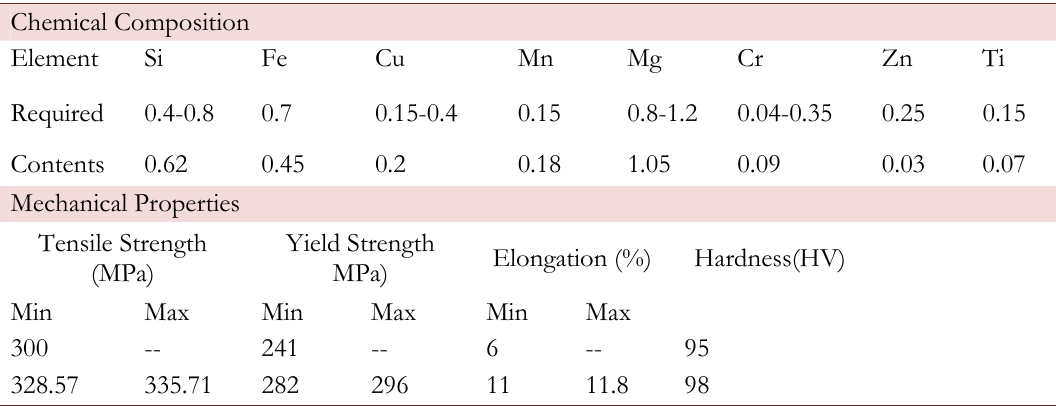
Table 2: Chemical composition and mechanical properties AA6061-T6.